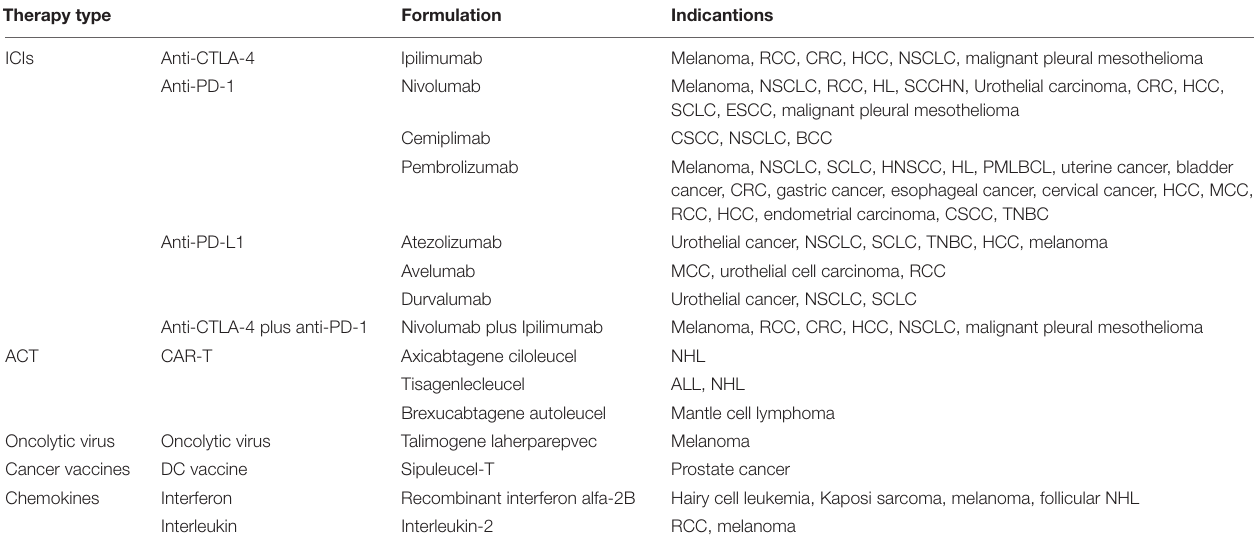
TABLE 1 | Summary of FDA-approved T cell-based immunotherapies. Therapy